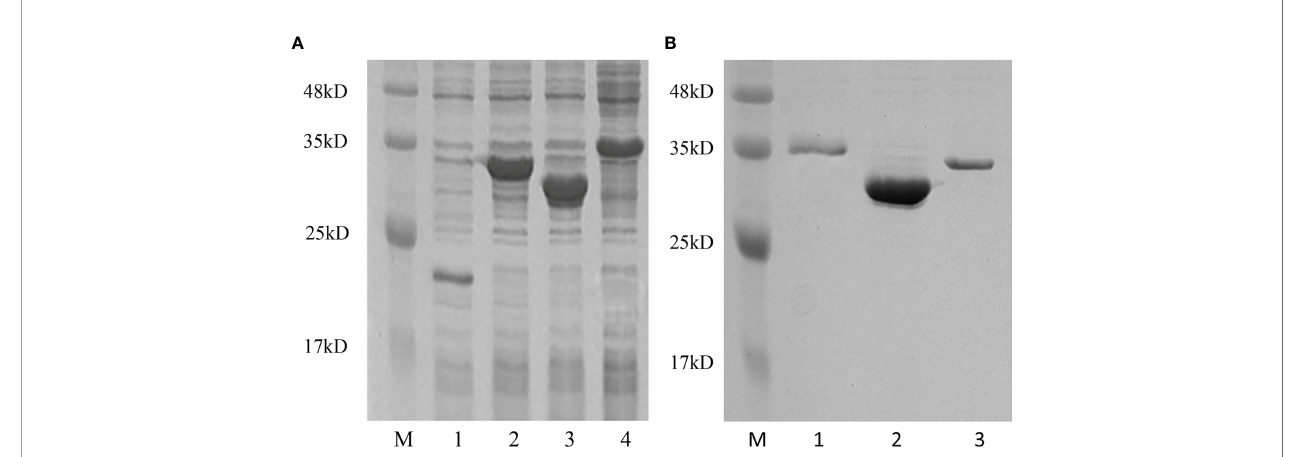
FIGURE 6 | Production and puri fi cation of recombinant Pf _IL-17A/F1, 2 and 3 proteins by SDS-PAGE. (A) Production of r Pf _IL-17A/F1, 2 and 3 proteins. Lane 1: Tag protein; Lane 2: r Pf _IL-17A/F1 protein; Lane 3: r Pf _IL-17A/F2 protein; Lane 4: r Pf _IL-17A/F3 protein. (B) Puri fi cation of three r Pf _IL-17A/Fs proteins. Lane 1: